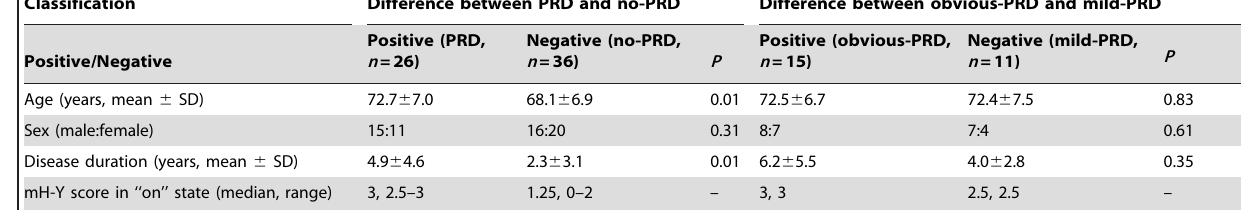
Table 1. Characteristics of the participants.